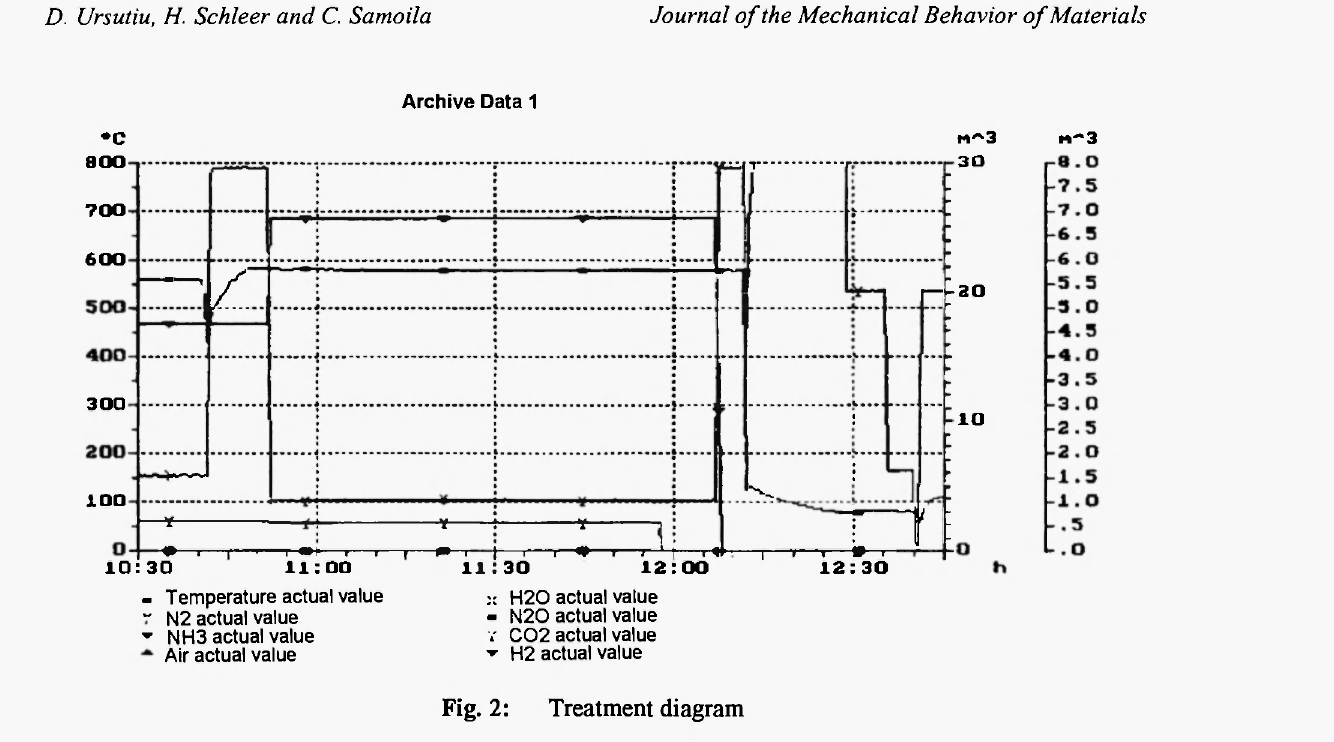
Fig. 2: Treatment